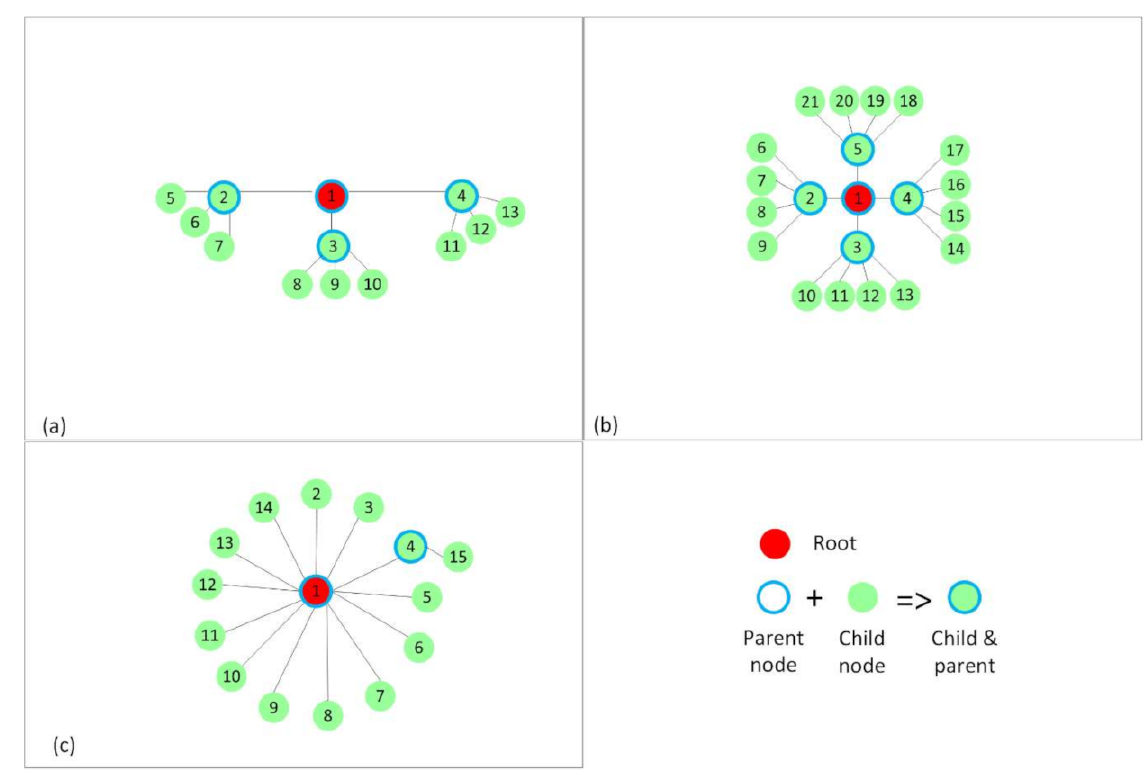
Figure 5. The RPL trees or topologies formed with interference between nodes of the same rank. ( a ) RPL tree showing a topology in which each node, apart from the leaf nodes, has 3 children. ( b ) RPL tree showing a topology in which each node, apart from the leaf nodes, has 4 children. ( c ) RPL tree showing a star topology with the root node placed in the center.